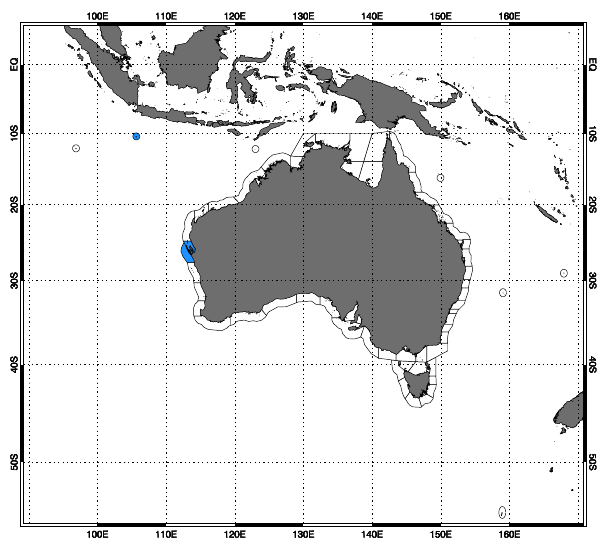
Fig. 6. Desired warning scheme for the Java 2006 event. Coastal zones assigned a marine threat are shaded in blue.